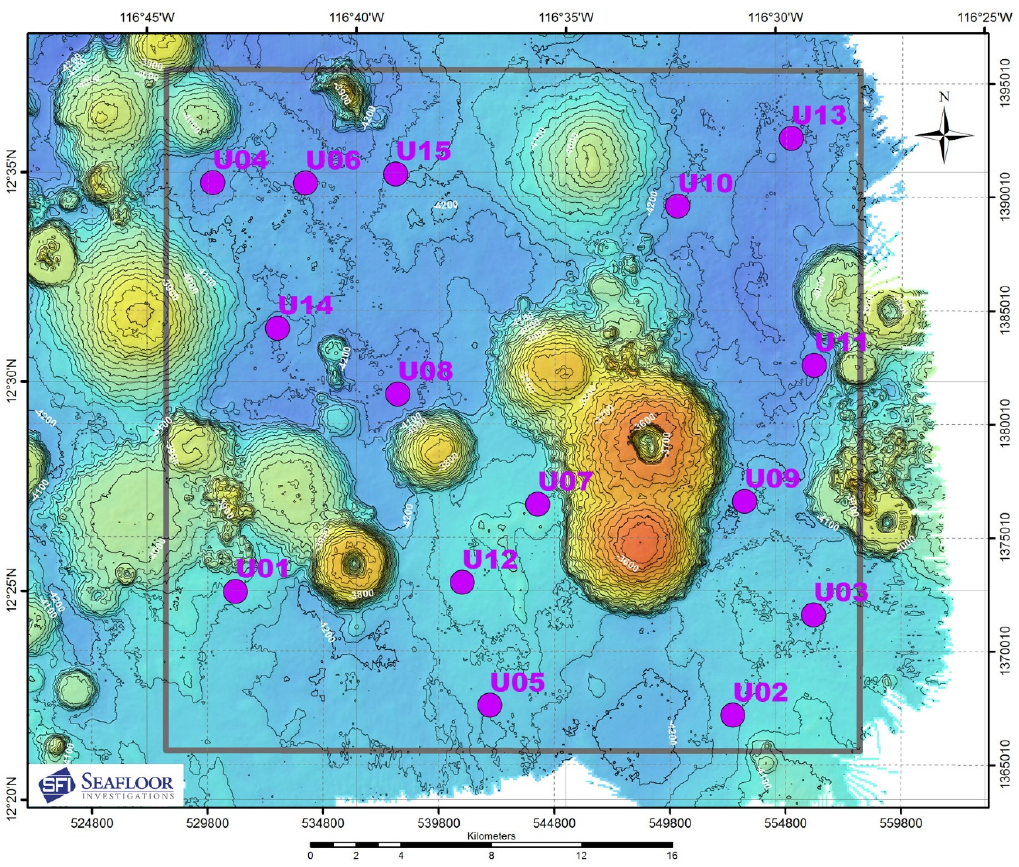
Figure 3. The Clarion-Clipperton Zone (CCZ) is not a homogeneous abyssal plain of mud 4000 m deep. In fact, the depth range of the CCZ is from 3950 m to 5150 m, a range of 1200 m. It is also punctuated by abundant seamounts. Recent expeditions with high-resolution multibeam bathymetry are revealing extremely abundant small seamounts in the eastern CCZ, here illustrated by example from the recent ABYSSal baseLINE ‘ABYSSLINE’ cruise in March 2015. There are 14 definable seamounts typically 200–500 m in height within just one 30 ˆ 30 km sampling strata within the overall 58,000 km 2 exploration claim. Image credit: Craig R Smith, ABYSSLINE